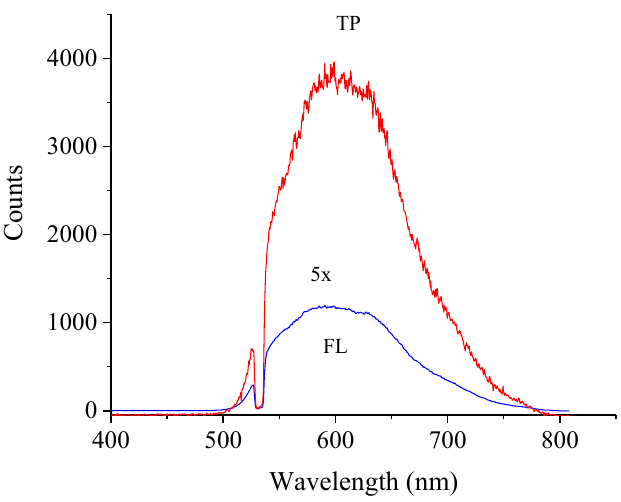
Figure 2. Fluorescence spectra of the g -C 3 N 4 powder with 532 nm excitation, Nd-YAG laser, 15 Hz, 6 ns-pulse. The lower intensity spectrum was measured over one laser pulse and 5mW laser power. It was also scaled for camera gain and further scaled 5X for clarity. The higher intensity spectrum was measured over one laser pulse and 1.4 W laser power.